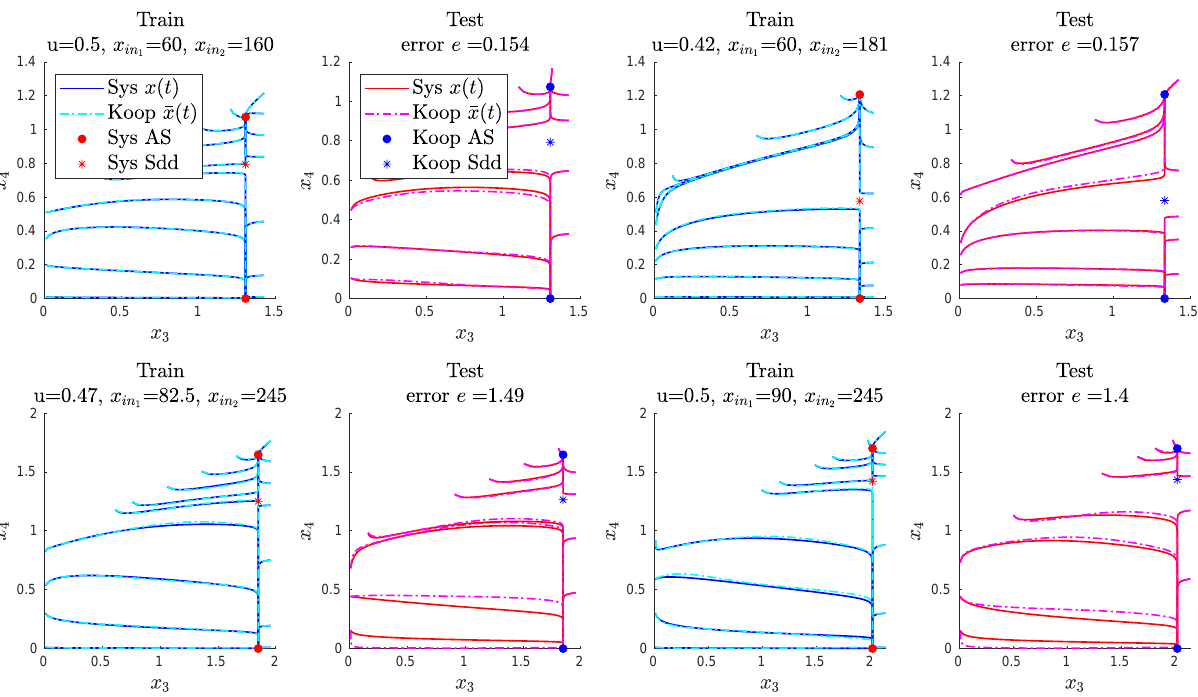
Figure 6: Training orbits, testing orbits, and fixed points with their respective approximations based on Koopman linear predictor and anal- ysis algorithms.